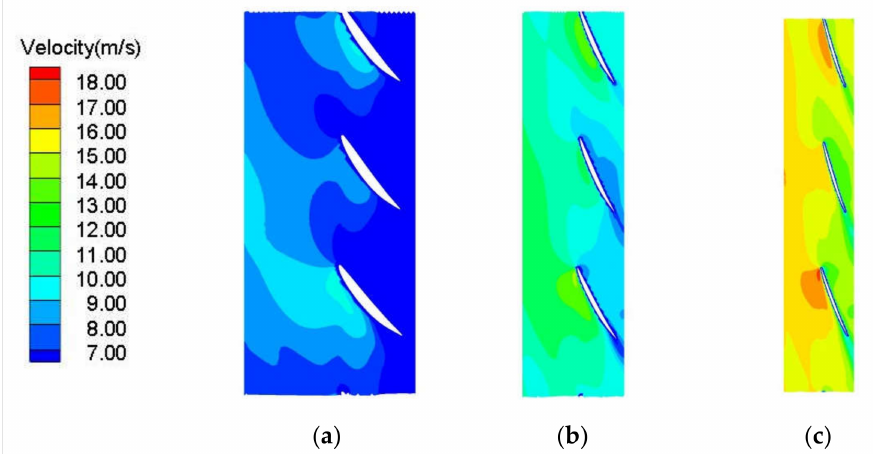
Figure 16. Velocity contour of each span in scheme II ( Q = Q des ). ( a ) Span = 0.1. ( b ) Span = 0.5. ( c ) Span =